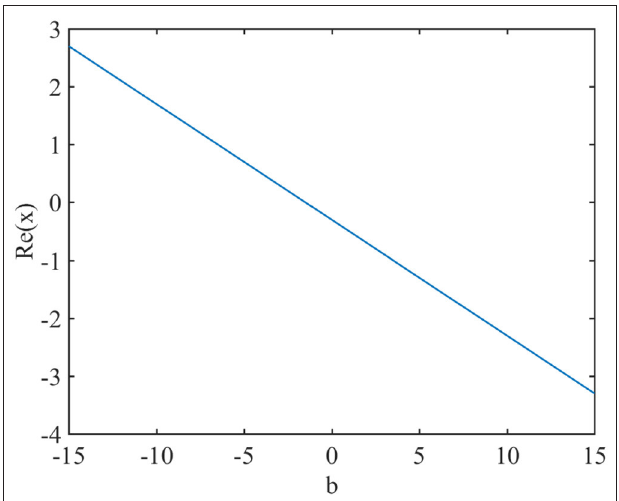
TABLE 2 | Correlating the real parts of the poles in the complex plane and locations of maximum heights in physical space. (A) First-order rogue wave Physical space: maximum height Complex plane (by regarding x as complex): occurs at x = 0 Poles are located at i /4 – t ± {[4( t – i /8) 2 + 1/4] 1 / 2 } i As time t evolves, the turning point of the trajectory occurs at t = 0 (B) Second-order rogue wave Complex plane (by regarding x as complex): Physical space: Poles of u 2 = zeros of the denominator of (1) Central maximum occurring Equation (7): at x = 0 at time t = 0 (1) At t = 0, (2) Two smaller maxima occurring pole is located at 0–0.687 i at the sides, i.e., x = ± 0.4514 (2) At t = ± 0.2075, pole is located at 0.4526 at time t = ± 0.2075 – 0.3285